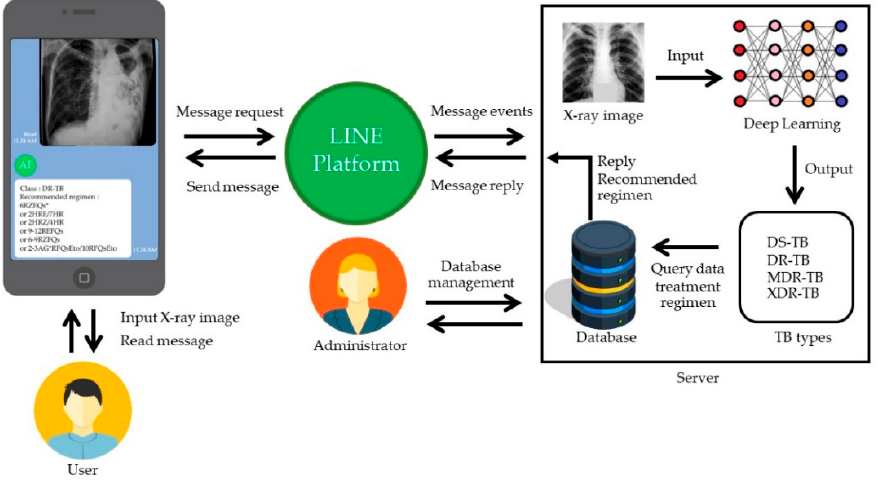
Figure 13. The design framework of DBOQS for the case study.